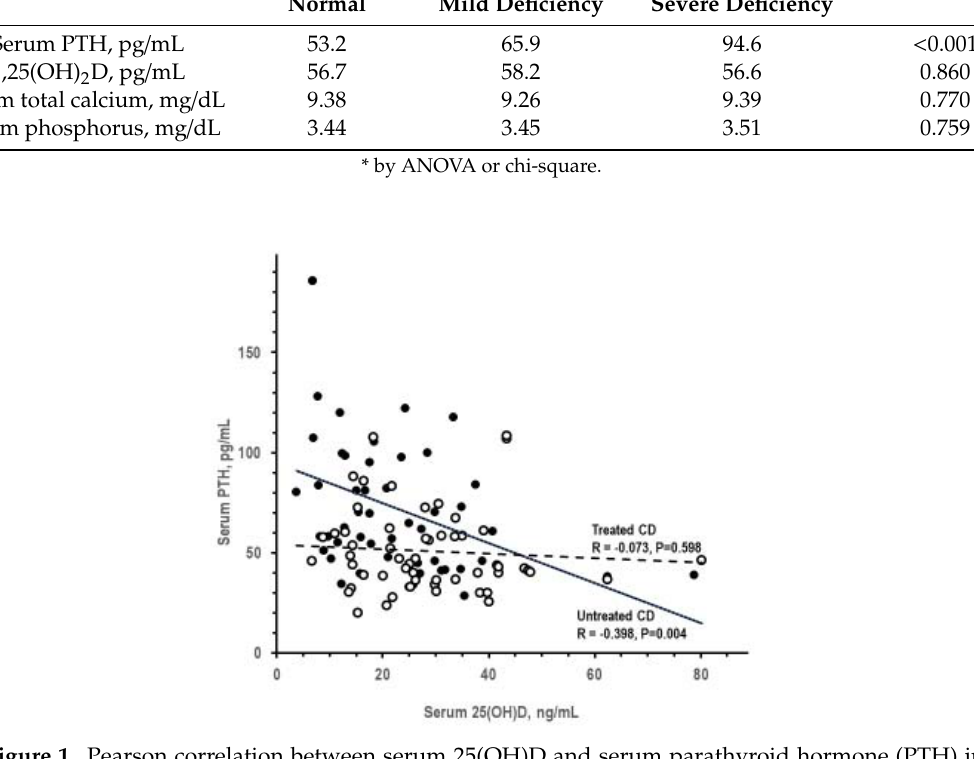
Figure 1. Pearson correlation between serum 25(OH)D and serum parathyroid hormone (PTH) in untreated CeD and treated CeD (closed and open symbols, respectively).